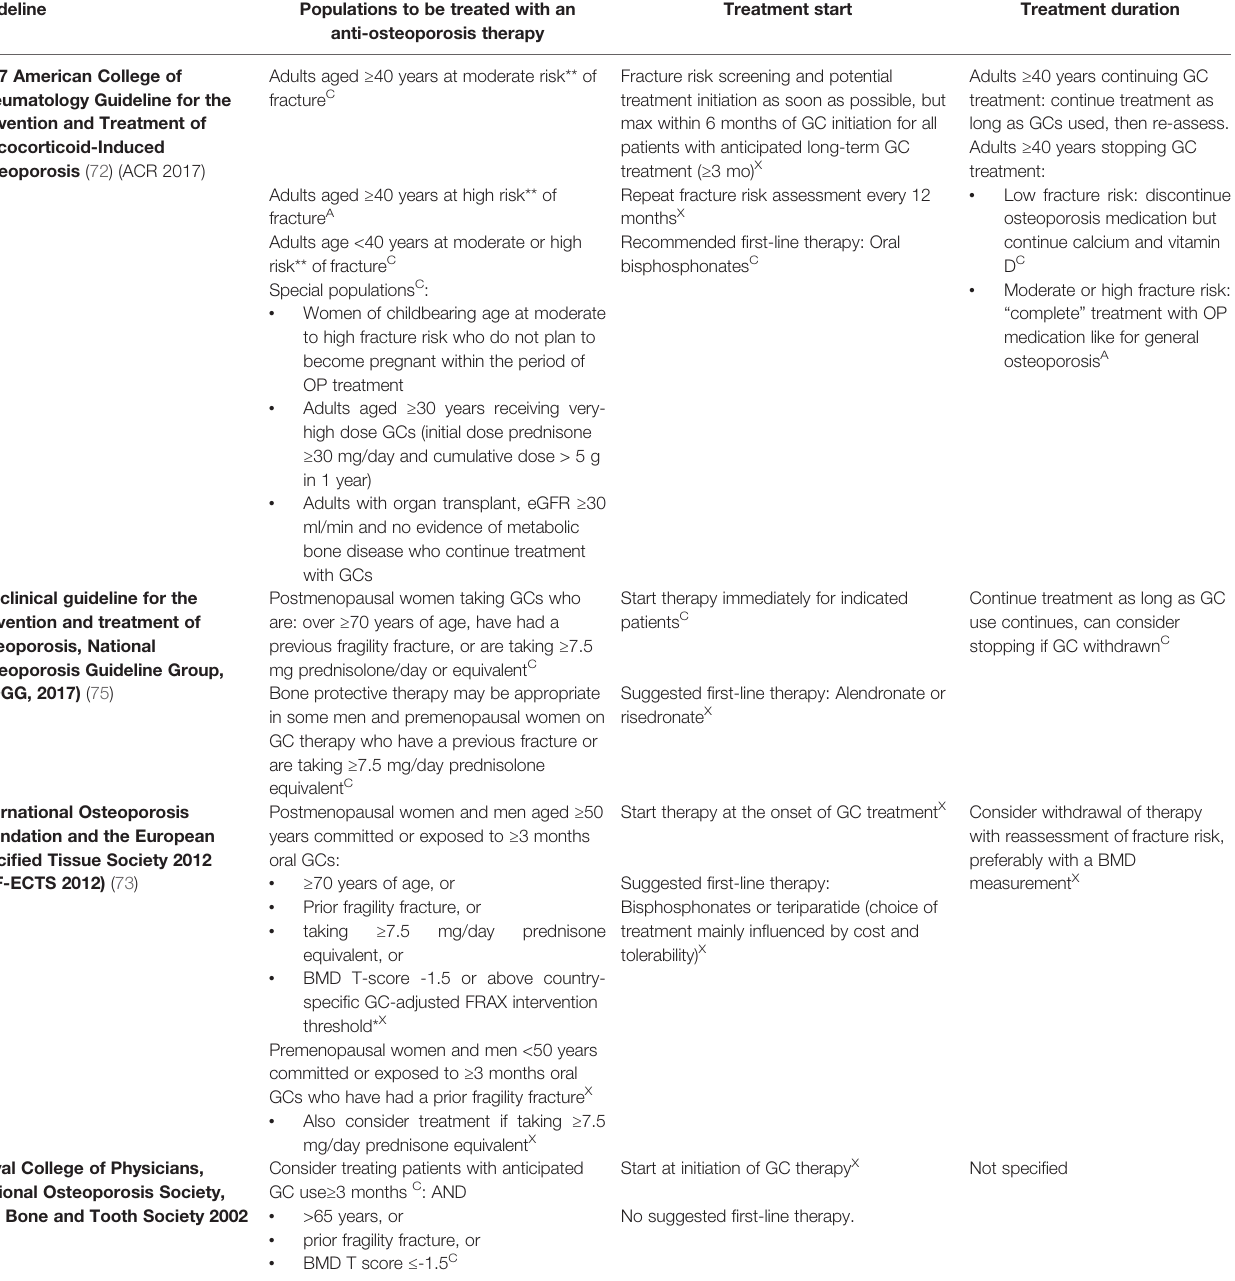
TABLE 1 | Summary of guideline recommendations on anti-osteoporosis treatment for adults with glucocorticoid use.